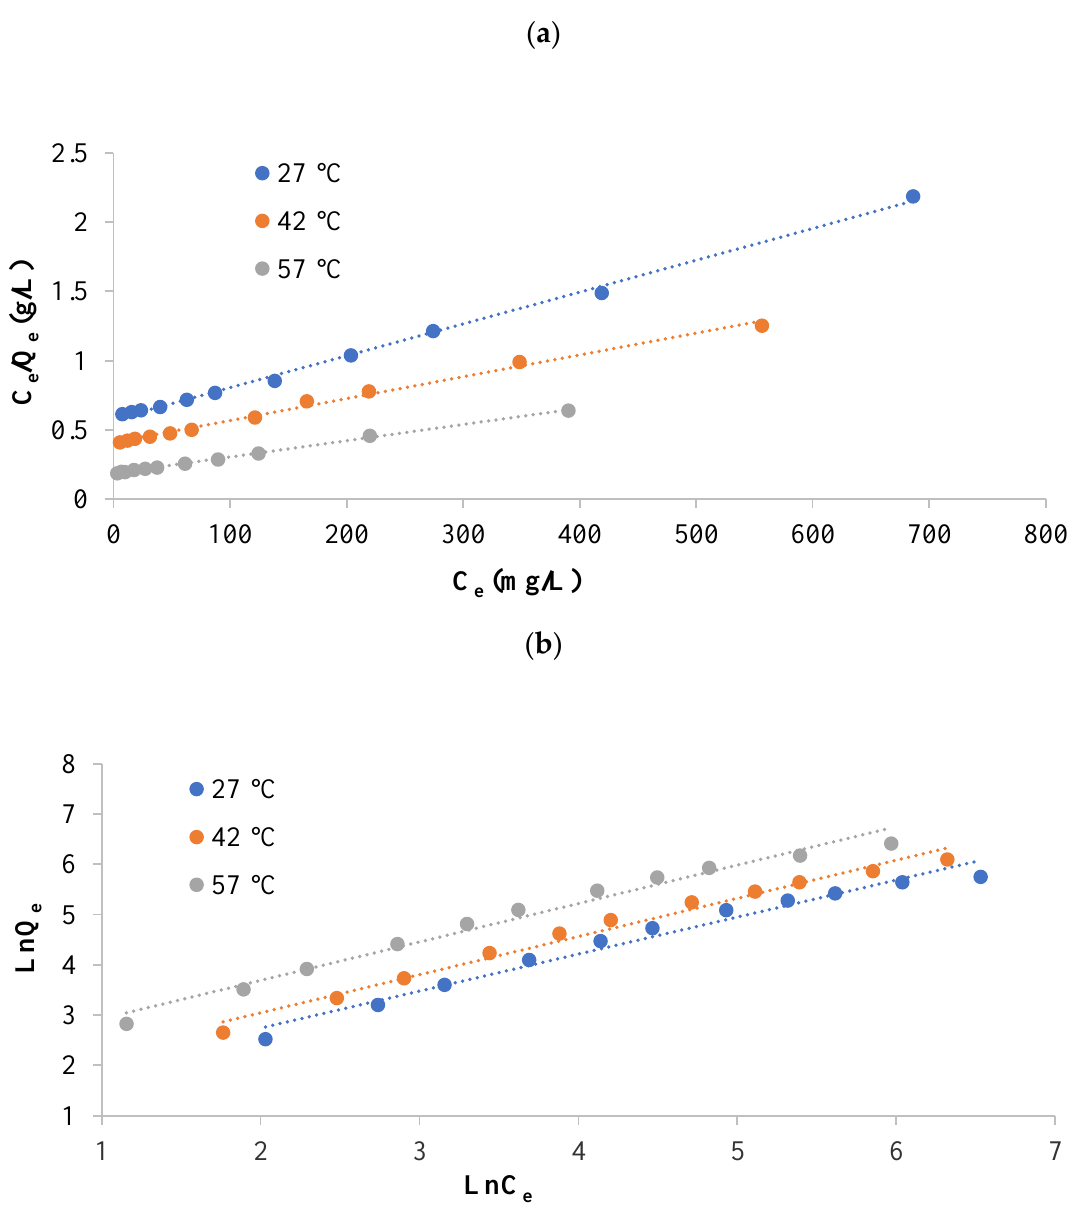
Figure 7. Isotherm plots of Langmuir ( a ) and Freundlich ( b ) for adsorption of CR by Zn/Cu-FVSP.